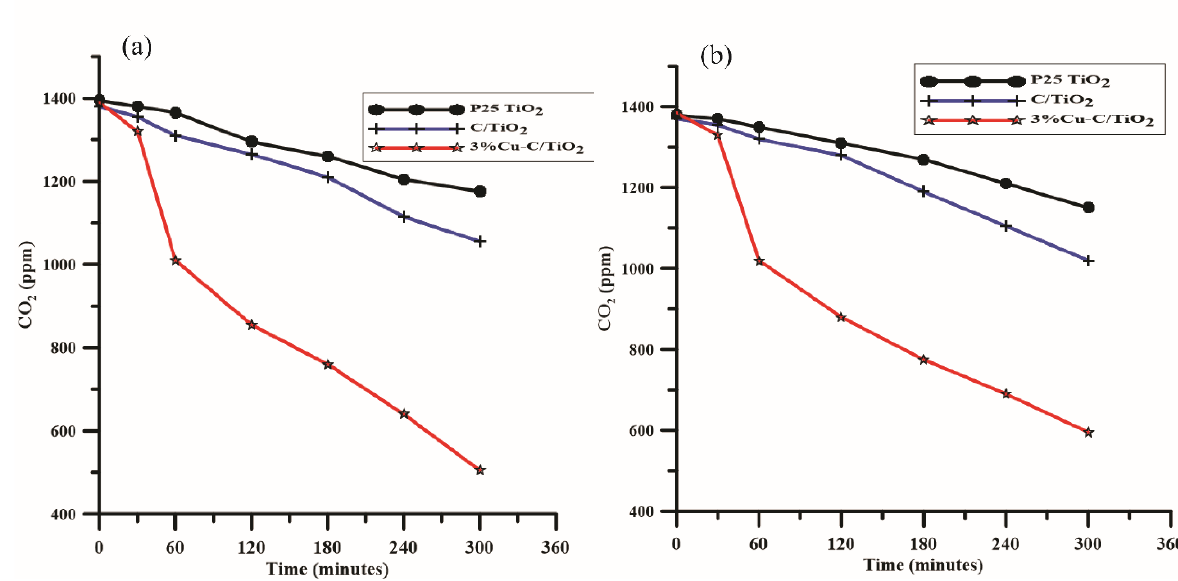
Figure 2: Time dependence on the photocatalytic reduction of CO Figure 2. Time dependence on the photocatalytic reduction of CO